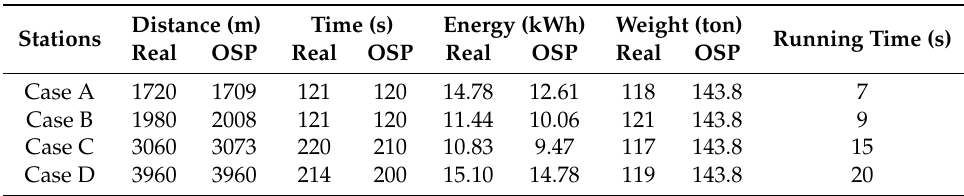
Table 6. Algorithm